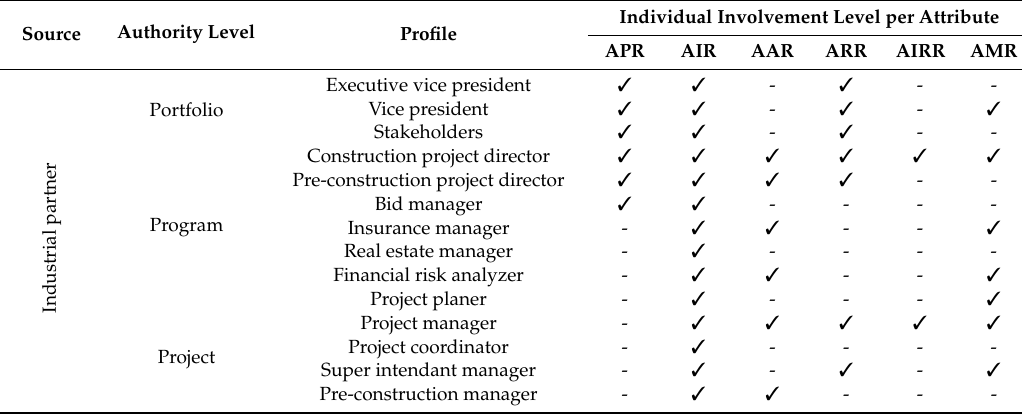
Table 7. Qualified individuals in the industrial partner